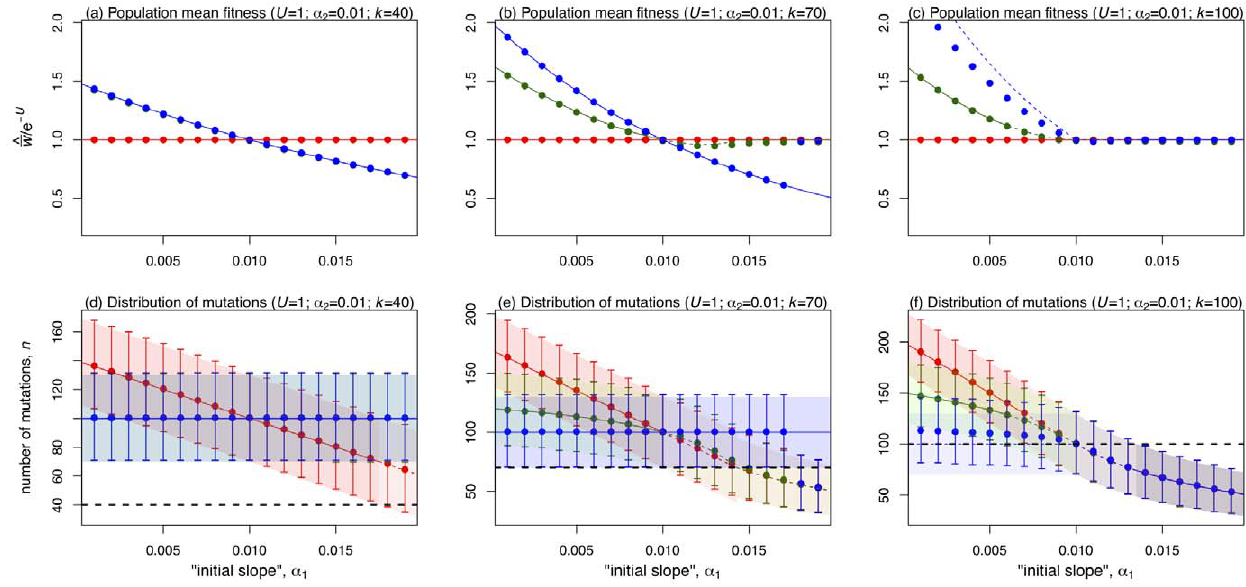
Figure 4. Results for populations at mutation-selection equilibrium in the special case b ~ 0 . Plots show the equilibrium mean fitness (a)– (c) and the genetic consitution of the population (d)–(f). The x-axes show the decline in fitness for the initial k mutations, a 1 . The centre of the plots show results where a 1 ~ a 2 , such that no epistasis applies; left of centre ( a 1 v a 2 ) shows negative epistasis, and right of centre ( a 1 w a 2 ) shows positive epistasis. Analytical results were taken from Table 2. All other conventions are as for Figure 3. doi:10.1371/journal.pone.0048382.g004 PLOS ONE |